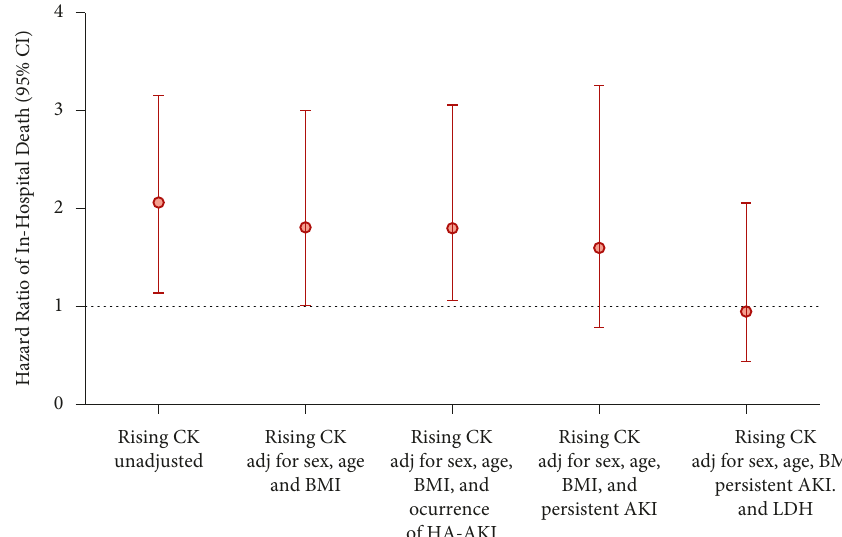
Figure 5: Unadjusted and adjusted hazard ratios for risk of death according to ascendent CK trajectory. Fully unadjusted and multivariable- adjusted hazard ratios and 95% confidence interval for mortality comparing the ascendent CK trajectory are shown. Adj, adjusted; BMI, body mass index; HA-AKI, hospital acute kidney injury; LDH, lactate